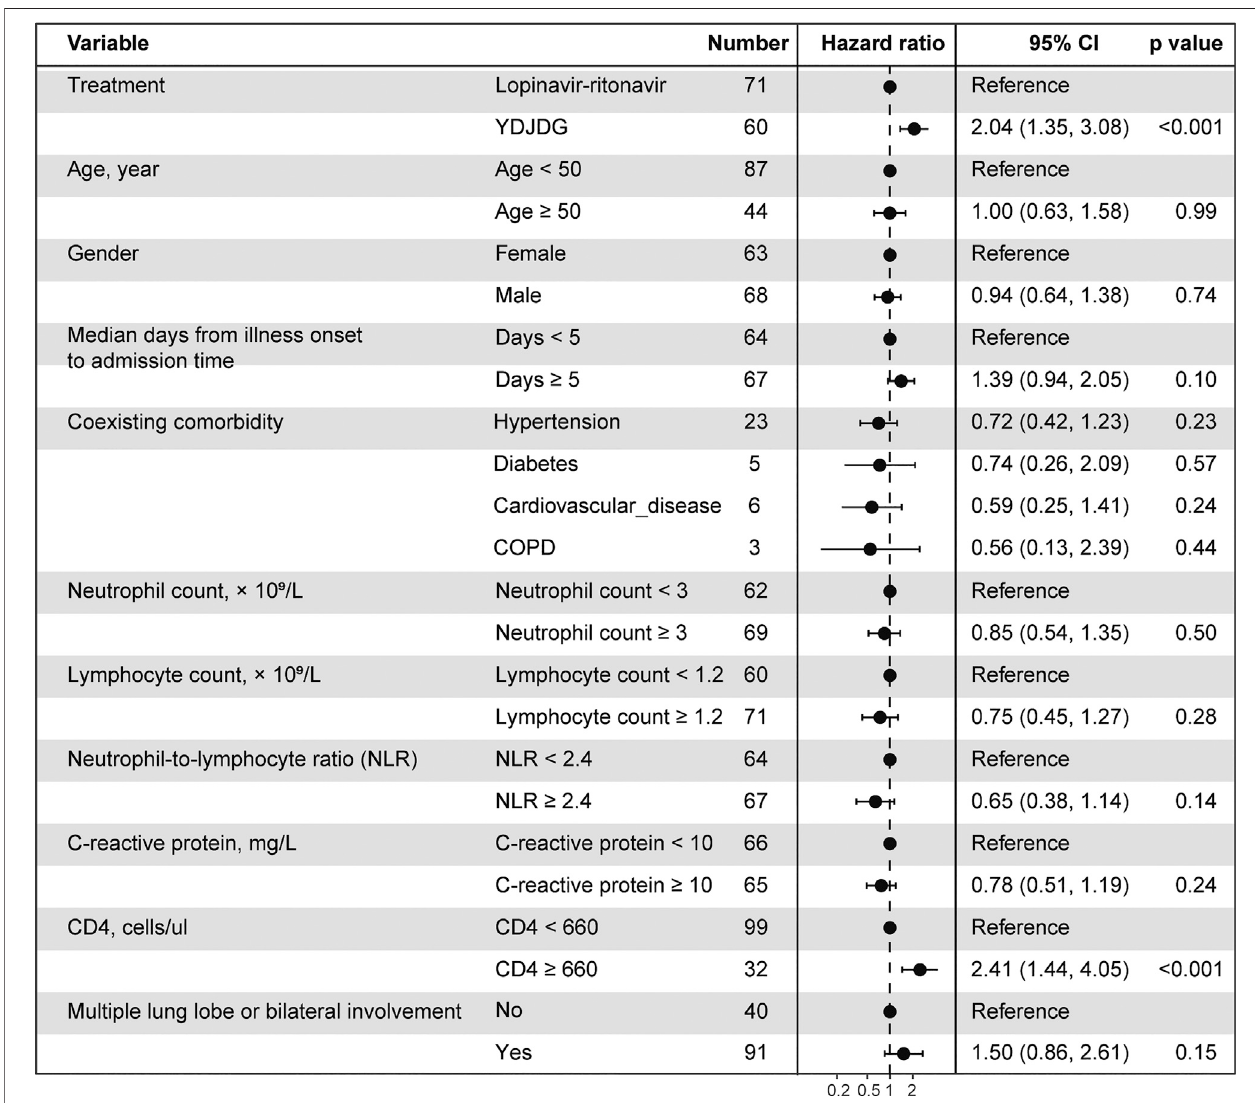
FIGURE 3 | Cox regression analyses for proportion recovery in patients with COVID-19. YDJDG therapy and CD4 ≥ 660 cells/µL are signi fi cant factors affecting recovery ( p < 0.001 for both). COVID-19, Coronavirus disease-2019; YDJDG, Yindan Jiedu granules.